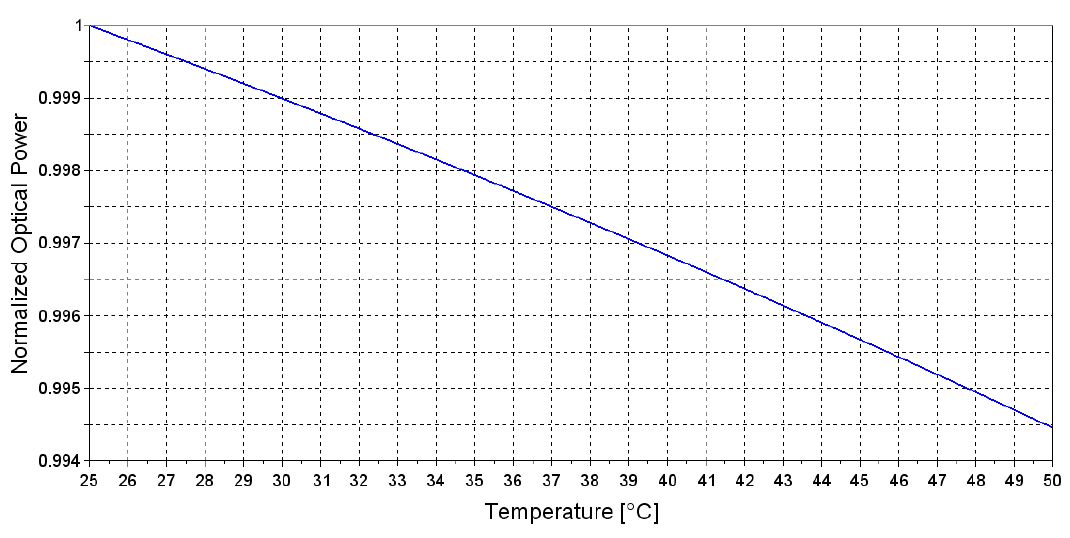
Figure 9. Theoretical evaluation of correlation between emitted optical power and temperature.